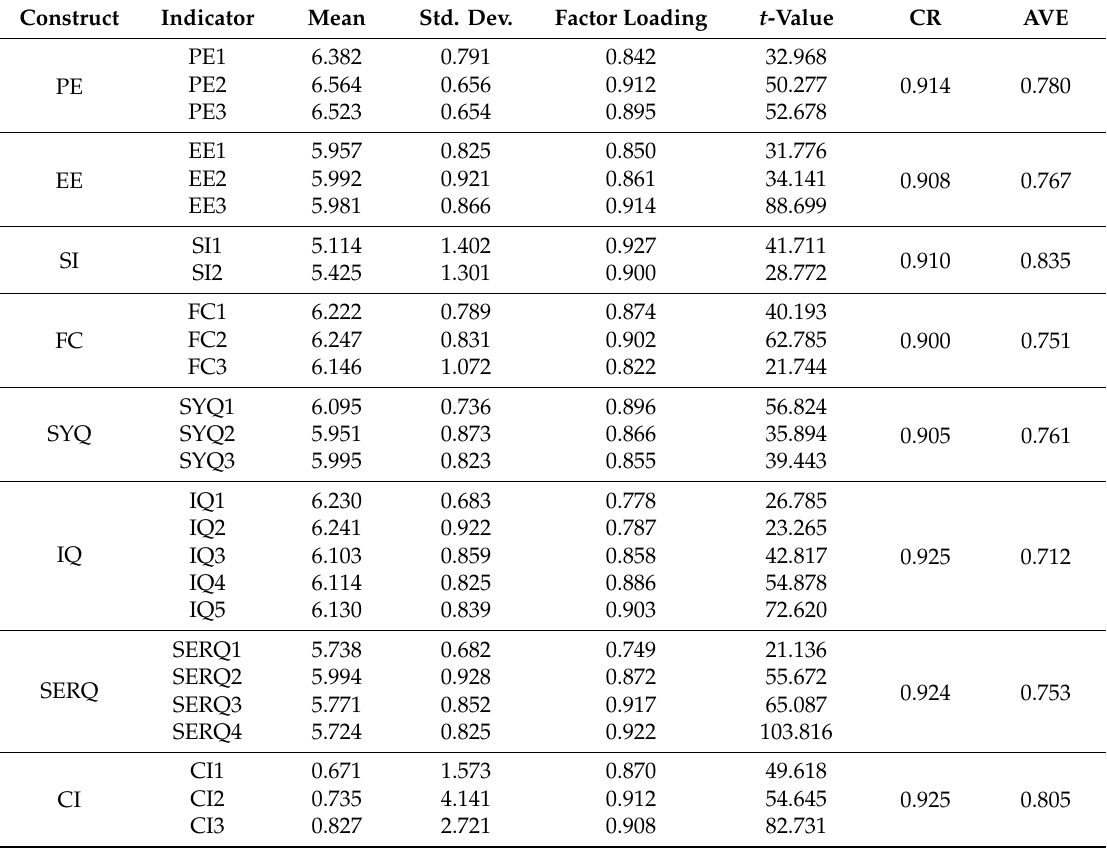
Table 2. Assessment of the measurement